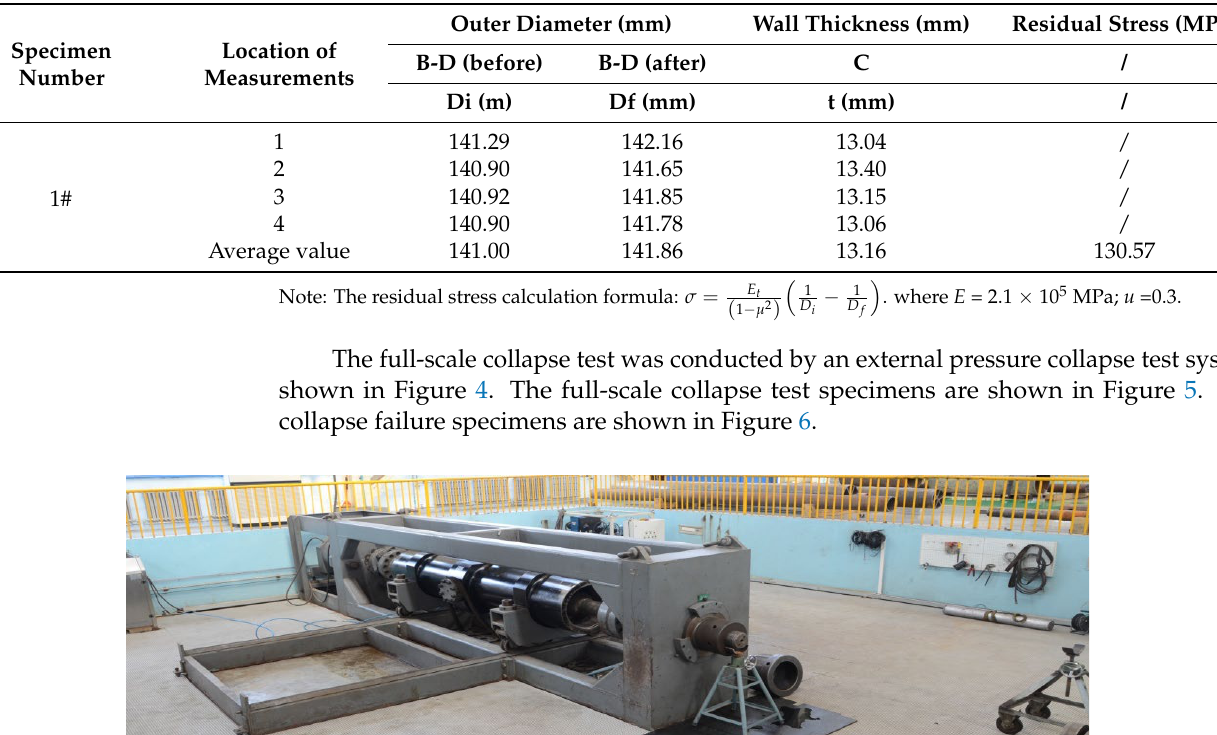
Table 2. Residual stress measurement results.